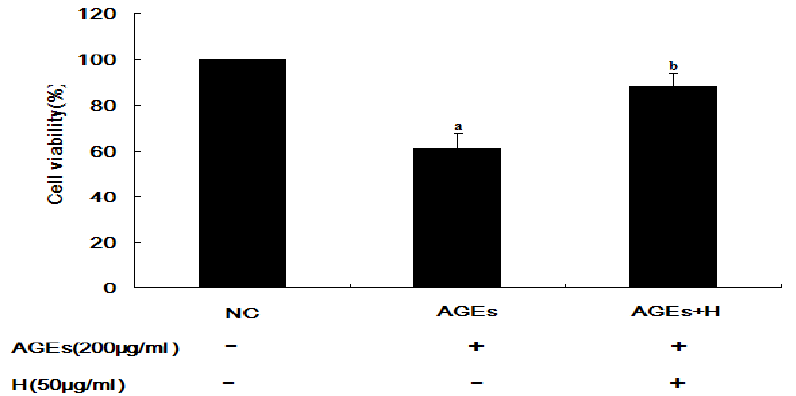
Figure 1. Hyperoside promotes cell viability and attenuates the effects of advanced glycation end products (AGEs). Cells were seeded in 96-well culture plates. After incubation at 37 °C for 24 h, the medium was replaced with fresh medium supplemented either with or without hyperoside (50 μ g/mL). After incubation for a further hour, AGEs (200 μ g/mL) were added to the cells for 10 min. The viability of ECV304 cells were detected after 24 h treatment with AGEs, either in the absence or presence of hyperoside. The results are shown as a percentage of negative control. ( a ) AGEs vs. NC ( p < 0.01); ( b ) AGEs + H vs. AGEs ( p < 0.05). NC, negative control; H, hyperoside.